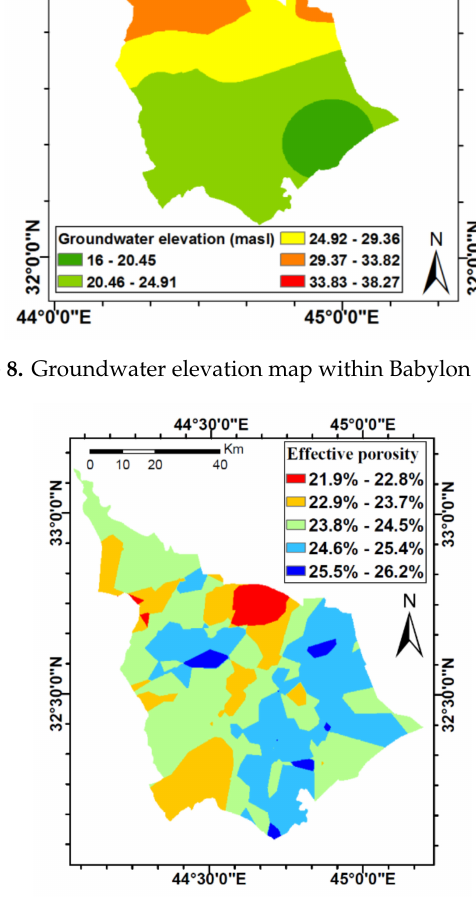
Figure 9. Actual e ff ective porosity map for Babylon aquifer (obtained from the Iraqi Ministry of Water Resources and Al-Qadisiyah University, Iraq).